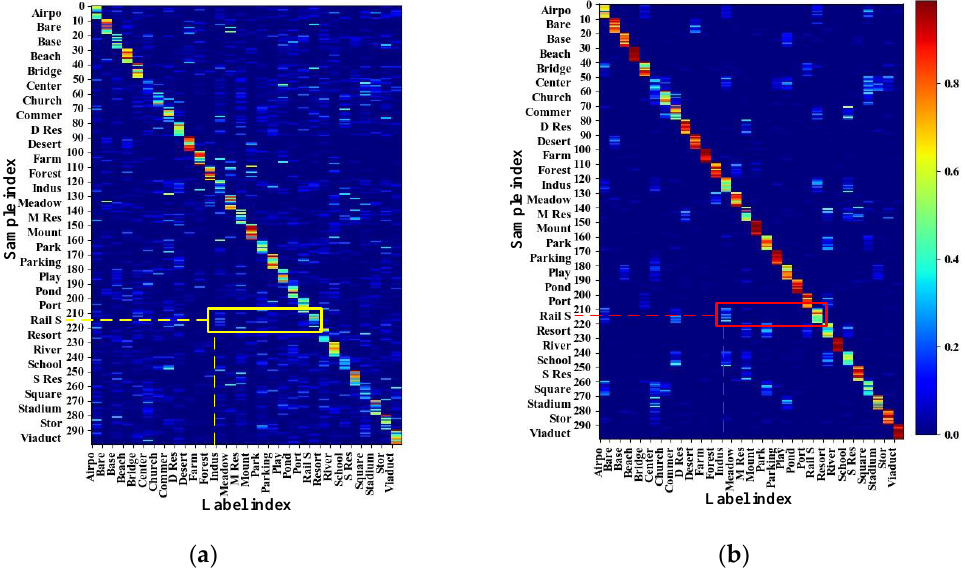
Figure 8. Label distributions produced by ( a ) D2LDL that leads to N d = 411 and ( b ) our method that leads to N d = 138. Since the training sample of AID-0.2 is too numerous (2000), we display only 10 samples per scene, and each row in the figure represents the label distribution of a sample. N d is the number of distorted distributions in all 2000 samples.